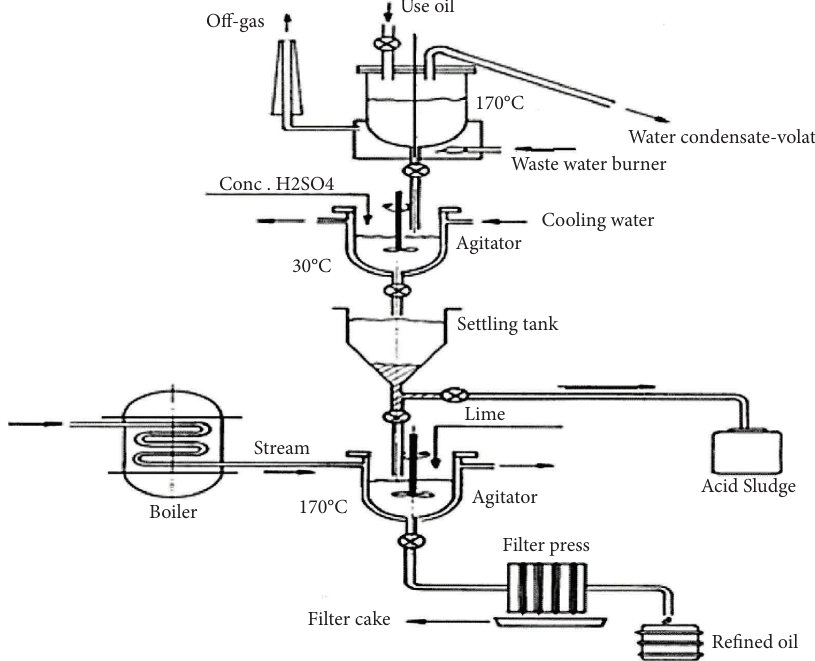
Figure 1: Small-scale acid-clay process. Source: [11, 12].